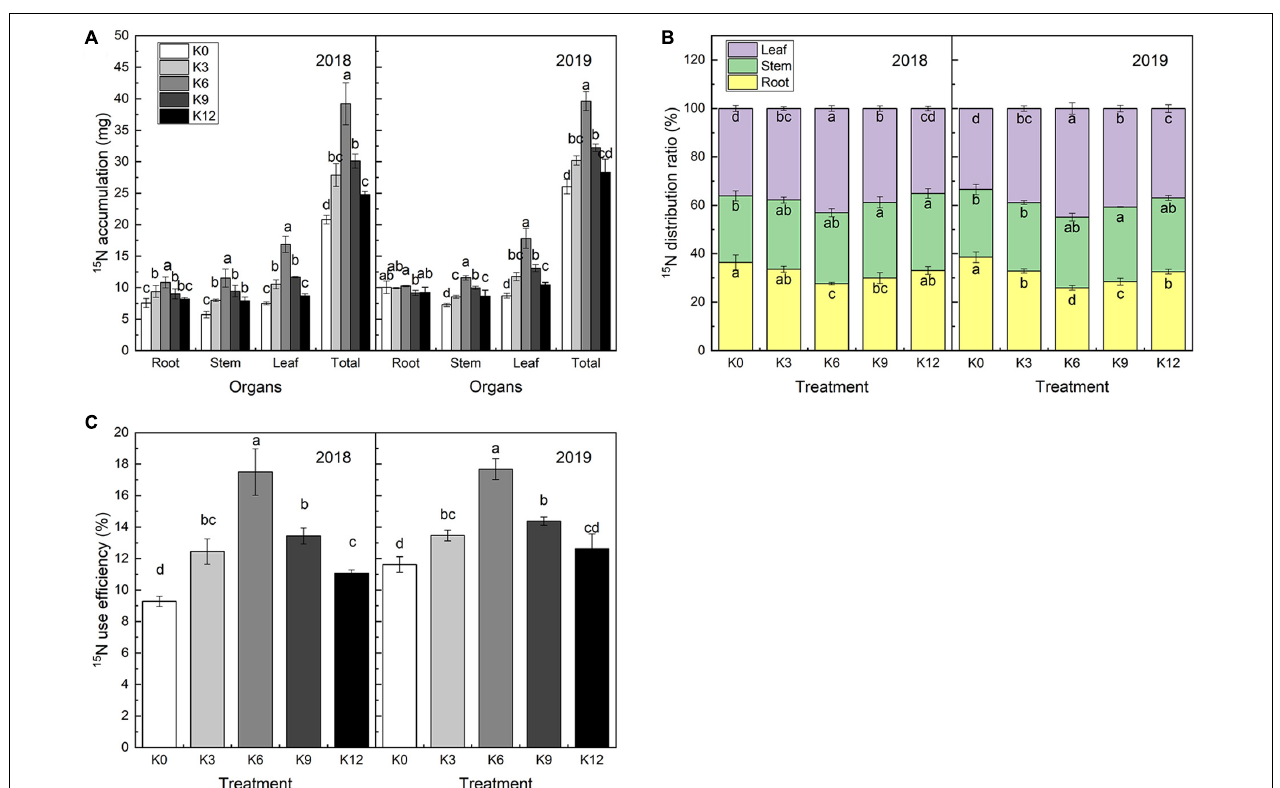
FIGURE 8 | 15 N accumulation (A) , 15 N distribution ratio (B) and 15 NUE (C) of M9T337 seedlings treated with K0 (0 mM K + ), K3 (3 mM K + ), K6 (6 mM K + ), K9 (9 mM K + ), or K12 (12 mM K + ) in 2018 and 2019. Each treatment had three biological replicates and the assays were repeated three times. Vertical bars indicate ± SD ( N = 3). Different letters indicate statistically significant differences ( P <